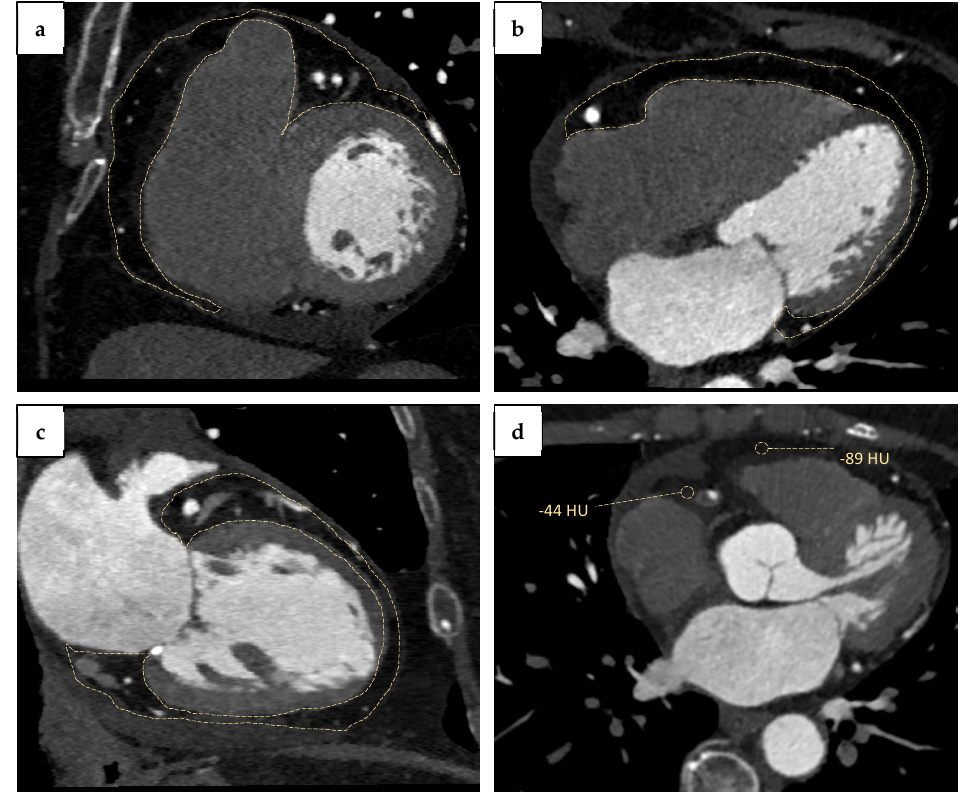
Figure 5. Cardiac computed tomography angiography (CCTA) assessment of epicardial adipose tissue (EAT) and peri-coronary adipose tissue (PCAT): ( a ) EAT in short-axis view; ( b ) EAT in four- chamber view; ( c ) EAT in two-chamber view (dashed line); ( d ) peri-coronary adipose tissue (PCAT) radiodensity ( − 44 HU) compared with radiodensity of EAT surrounding free left ventricle wall ( − 89 HU).